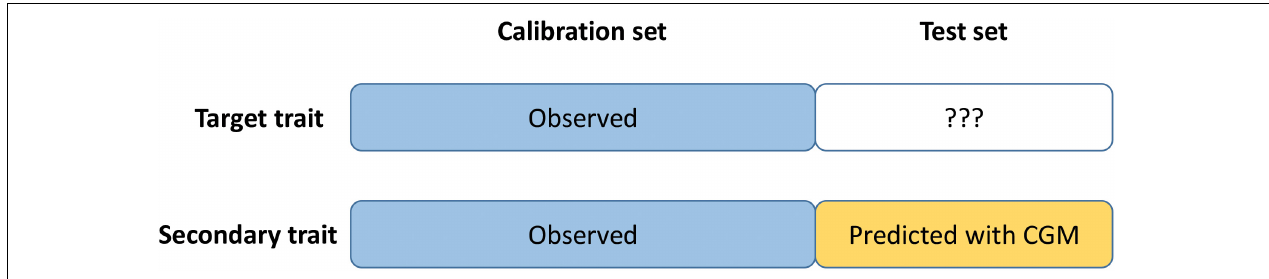
FIGURE 1 | Schematic representation of CGM-TAP. CGM-TAP is a trait-assisted prediction approach in which the secondary trait is predicted using crop-growth modeling instead of being phenotyped.